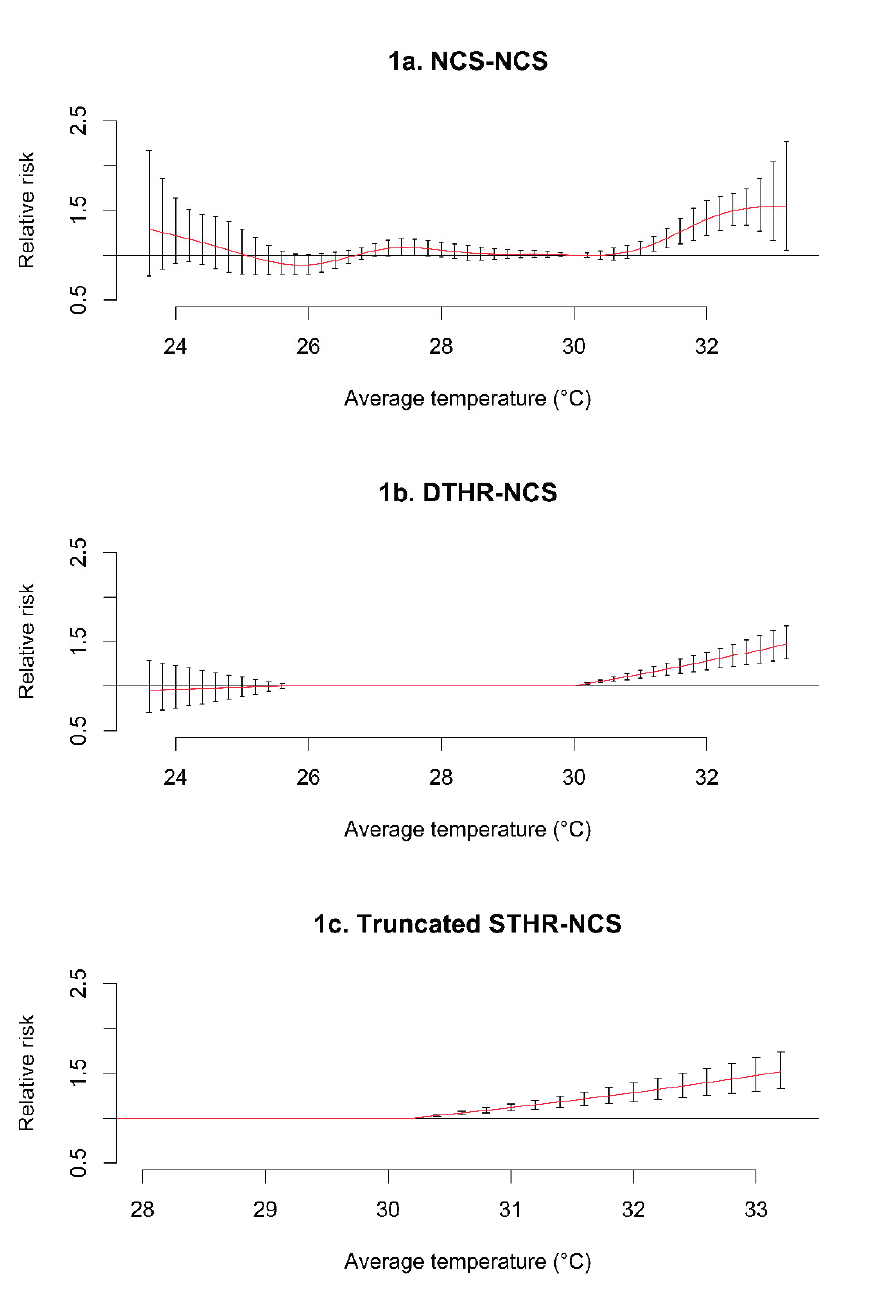
Figure 1. The model parameterization with NCS-NCS ( a ), DTHR-NCS ( b ), and truncated STHR-NCS ( c ); The DTHR-NCS thresholds were set at the two minimum points that were observed in NCS-NCS, while the upper threshold in the STHR-NCS was based on the best combination of the upper and lower threshold that minimized the lower temperature effect; NCS: natural cubic spline, STHR: single high threshold, DTHR: double high